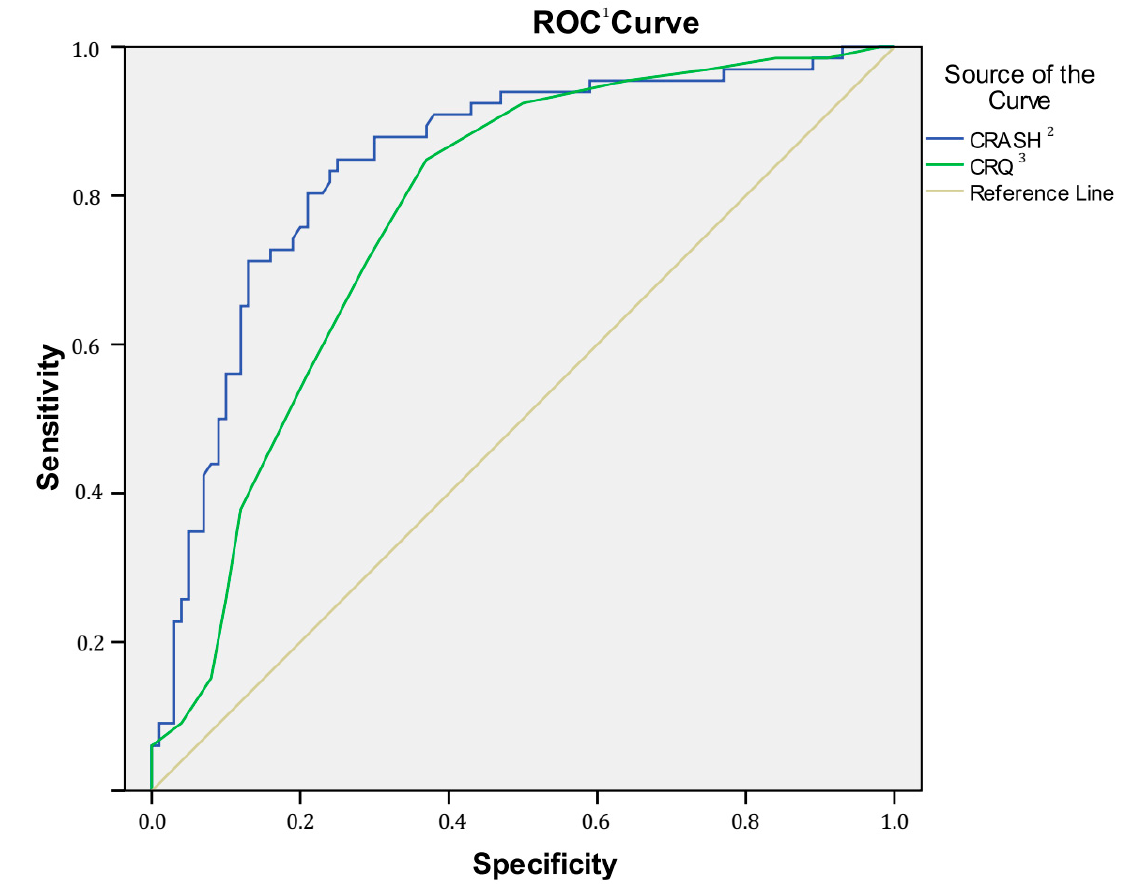
Figure 1. Curve between patients and controls (CRASH and cognitive reserve questionnaire CRQ). 1 ROC = receiver operating characteristic, 2 CRASH = Cognitive Reserve Assessment Scale in Health, 3 CRQ = Cognitive Reserve